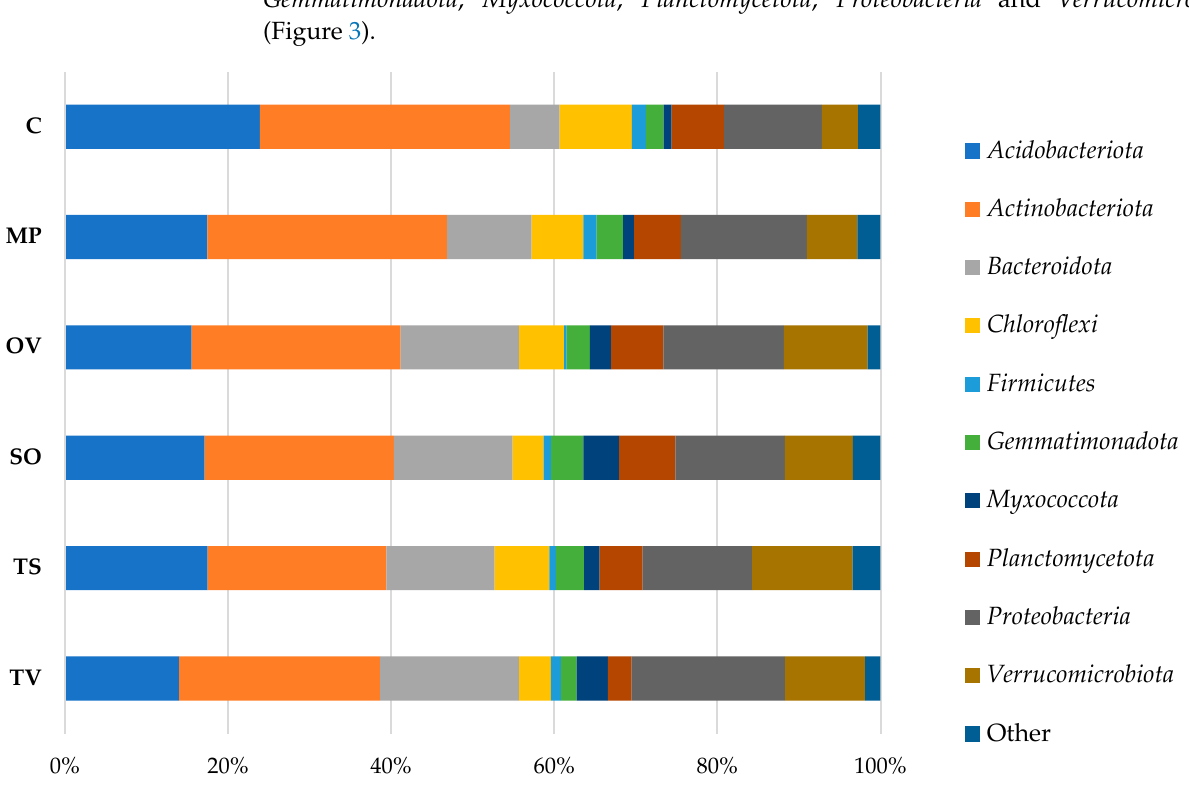
Figure 3. Taxonomic structure of bacterial phyla in Lamiaceae L. rhizosphere. MP is peppermint ( M. piperita L.), OV—oregano ( O. vulgare L.), TV—thyme ( T. vulgaris L.), TS—creeping thyme ( T. serpillum L.), SO—sage ( S. officinalis L.), C—control. ‘Other’ means phyla with abundance lower than 1% of total amount.